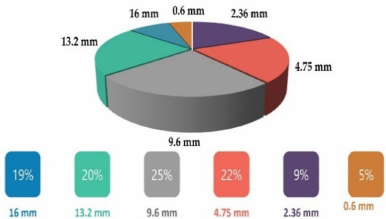
Figure 8. The contribution rate of aggregates with di ff erent maximum nominal sizes for Load